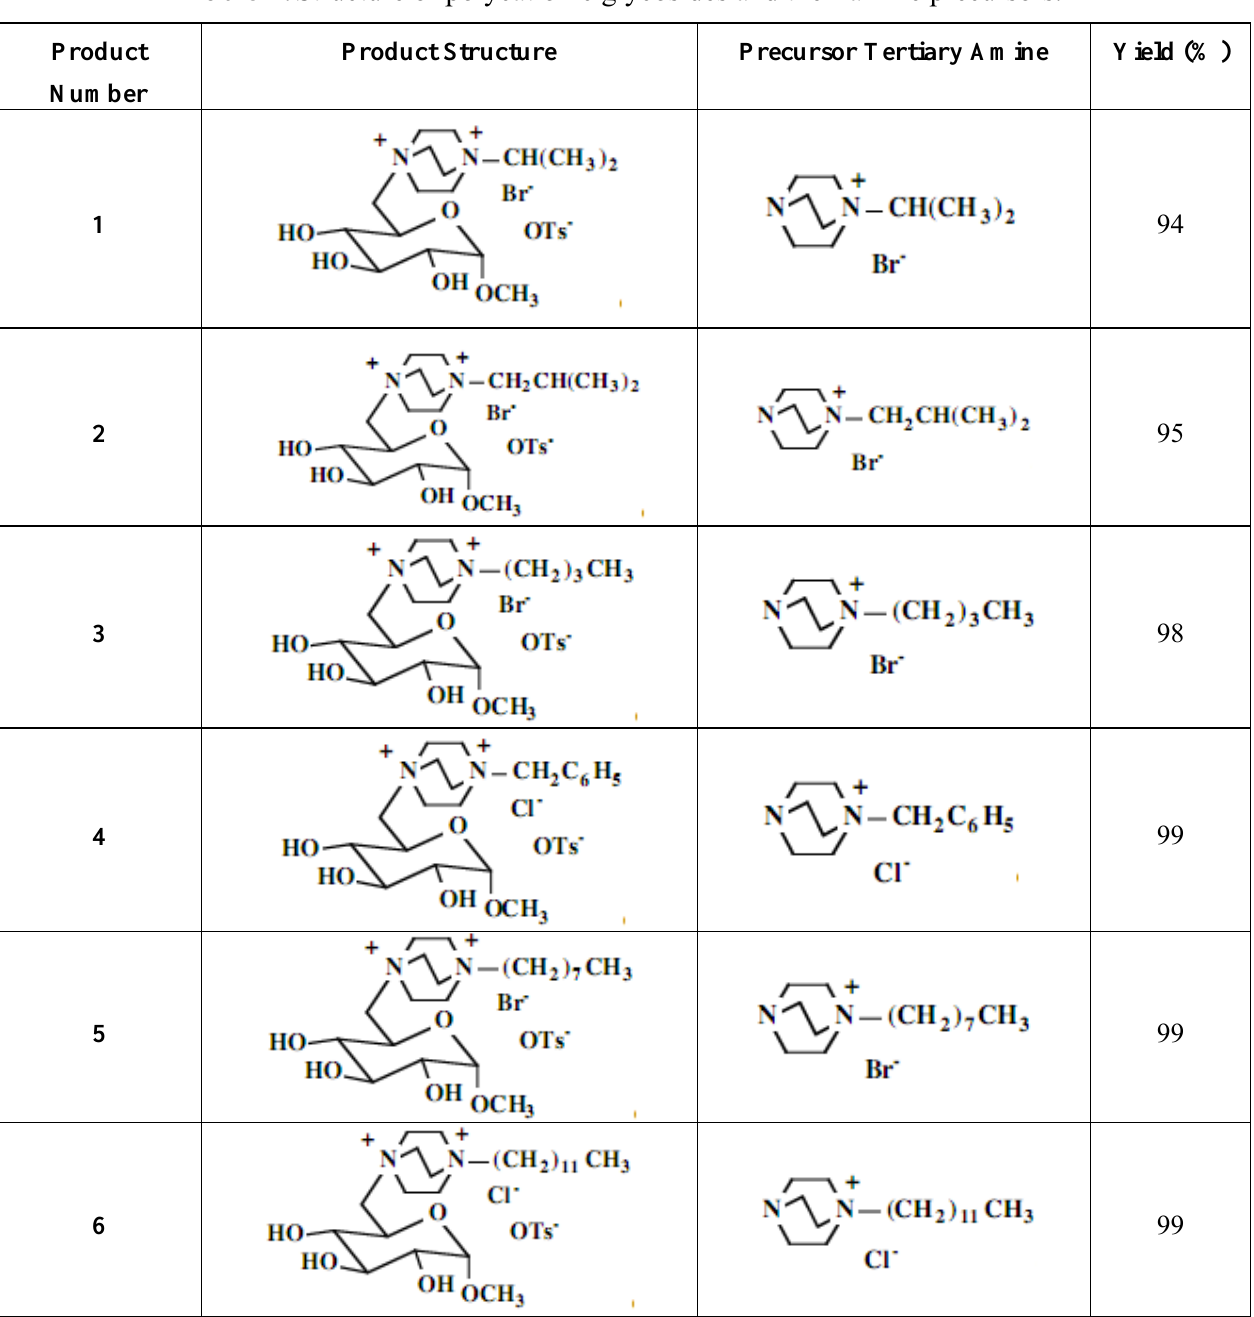
Table 1. Structure of polycationic glycosides and their amine